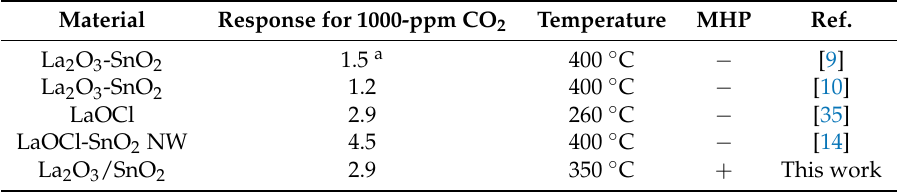
Table 2. Comparison of the properties of La-compound-based CO 2